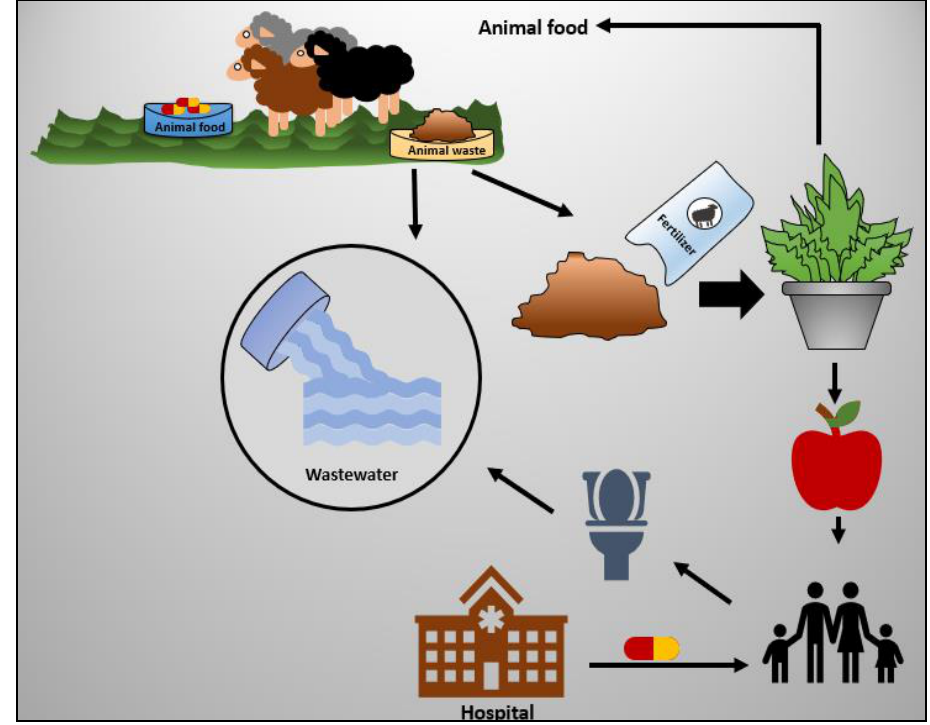
Figure 1. Possible routes of entry of antibiotics into wastewater. Adapted from [30] with modifications.